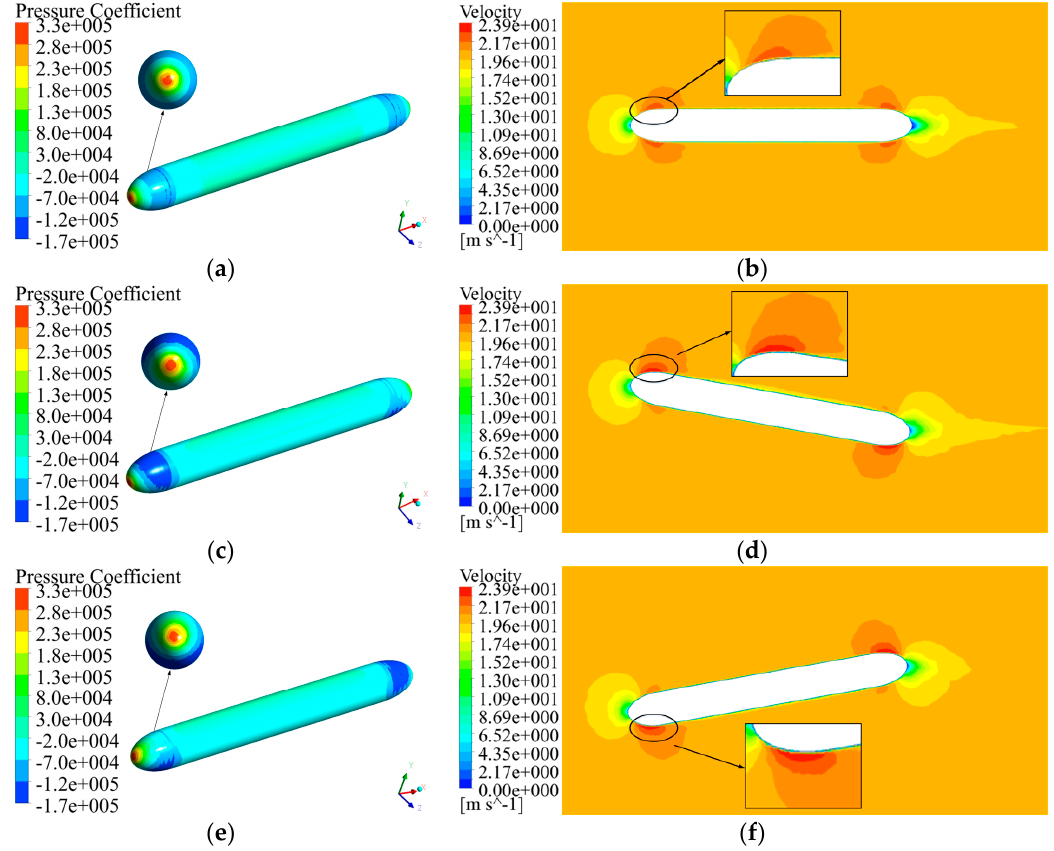
Figure 7 . Surface pressure coefficient and velocity field of the axisymmetric body Figure 7. Surface pressure coe ffi cient and velocity field of the axisymmetric